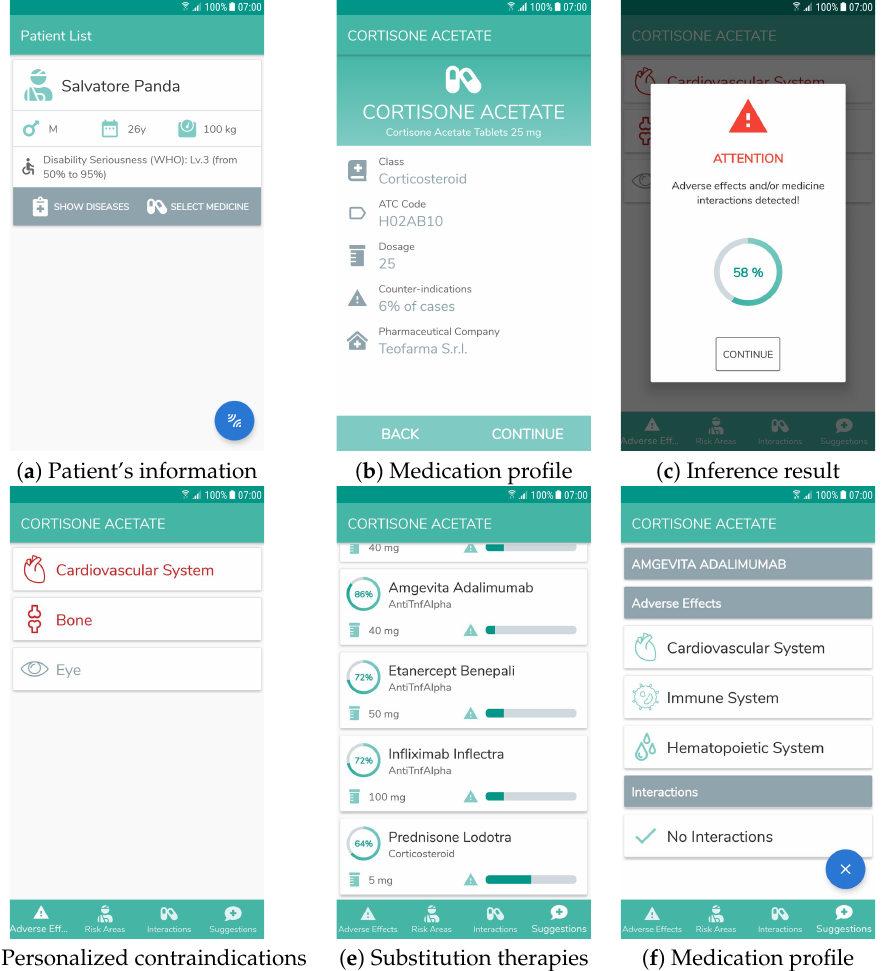
Figure 8. Screenshots of the mobile DSS user interface for Example